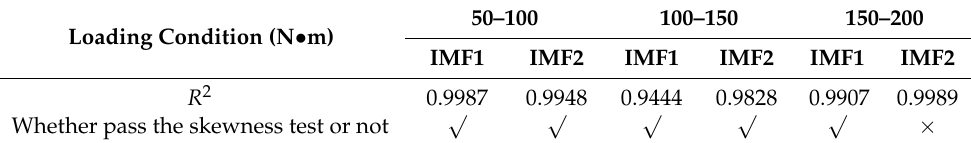
Figure 12. Statistical histogram of the IMF2 and GD-PDF-F curves. ( a ) 50–100 N•m; ( b ) 100–150 N•m; ( c )150–200 N•m. Table 5. Results of the signal denoising test. Table 5. Results of the signal denoising test.